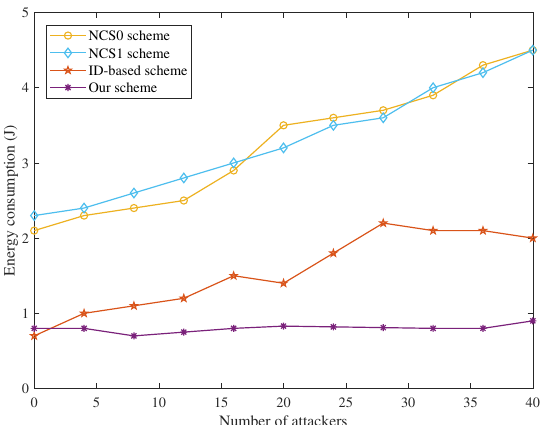
Figure 2. The energy consumption with T-S fuzzy trust model.